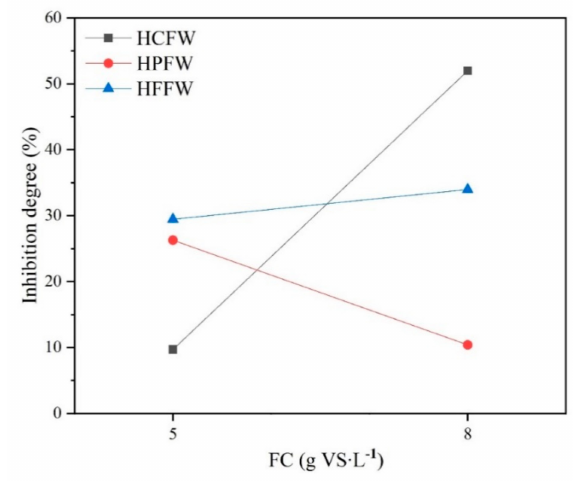
Figure 4. Inhibition degree of three feeding materials with 12 g · L − 1 salt addition.at 5 and 8 gVS · L − 1